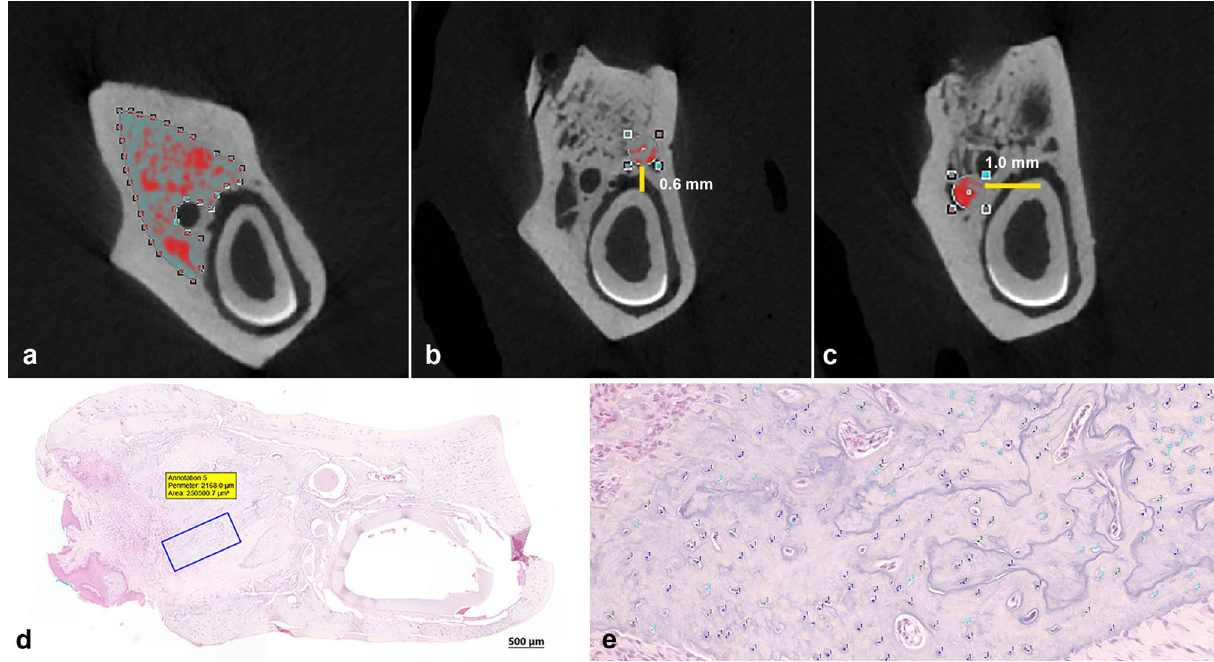
Figure 2. Micro-CT analysis. Manual delineation of the region of interest (ROI) encompassing the trabecular bone surrounding the extraction socket ( a ). Standardized round ROI (0.52 × 0.52 mm 2 ) containing trabecular bone in the lingual portion of the mandible, with 0.6 mm of vertical distance from the incisor ( b ). Standardized round ROI at the buccal portion of the mandible, with 1.0 mm of horizontal distance from the incisor ( c ). Cell quantification for measuring the necrotic bone indicator percentage. An area of interest was established using a fixed rectangular form of 0.25 mm 2 within the bone surrounding the extraction socket in all specimens at a magnification of ×20 ( d ). Fiji ImageJ (version 1.53c; NIH, Maryland, USA) was used to quantify the cells using cell counter plugins type 1 (osteocytes), type 2 (empty lacunae), and type 3 (pyknotic osteocytes) ( e injections in rats represent one and a half years in humans, and a 1-week discontinuation of medication in rats represents 6 months of medication discontinuation in humans. Blood samples were collected from the tail vein 1 week after the first injection; the last day of injections; the day of extraction; and 2, 4, 6, and 8 weeks post-extraction. All animals were euthanized by CO 2 inhalation. The mandibles of the rats were harvested and fixed in 10% formalin for micro-CT and histopathological analyses. Micro‑CT analysis of medication discontinuation. The obtained mandible specimens were analyzed using high-resolution micro-CT scanning on a Skyscan 1172 ® (Bruker, Kontich, Belgium). For the PO model, the imaging parameters were adjusted to an 80 kV source voltage, 124 μA source current, and 14.87 μm image pixel size, with a 0.5 mm aluminum filter and 0.4° angular steps. For the IP model, the imaging parameters were adjusted to a 70 kV source voltage, 141 μA source current, and 14.87 μm image pixel size, with a 0.5 mm alu- minum filter undergoing a 360° rotation with 0.3° steps. Following the scanning procedure, the datasets were reconstructed using NRecon 1.6.9.8 ® (Bruker, Kontich, Belgium) software. The reconstruction settings were adjusted with smoothing set to 3, ring artifact reduction set to 6, and beam hardening correction set to 20%. Each dataset was opened and adjusted using DataViewer ® (DataViewer, Brukerm Kontich, Belgium) software and the image analysis was performed using CT-Analyser (CTAn) Software ® (version 1.7.0, Bruker, Kontich, Bel- gium). The regions of interest (ROIs) were determined in the coronal plane and defined in three areas: (1) manual delineation encompassing trabecular bone surrounding the extraction socket, (2) standardized 0.52 × 0.52 mm 2 round ROI containing the trabecular bone close to the lingual surface of the mandible (1.0 mm from the inci- sor), and (3) standardized 0.52 × 0.52 mm 2 round ROI containing trabecular bone close to the buccal surface of the mandible (0.6 mm from the incisor) (Fig. 2a–c). The images were segmented into binary images using a Gaussian filter and a fixed threshold with a lower value of 70 and an upper value of 224 to extract the mineralized